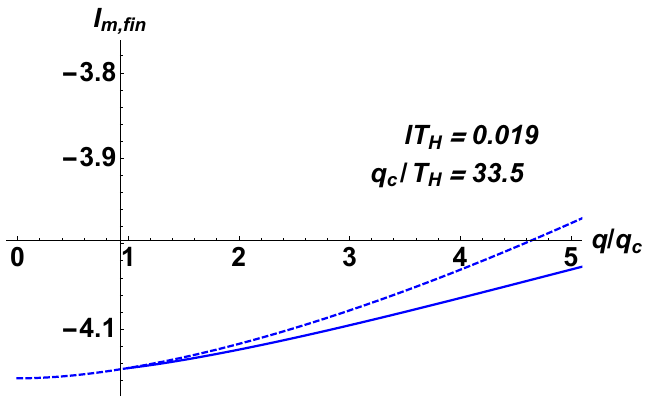
Figure 3 . I m;fin as a function of q=q c at lT H = 0 : 019 with T H = 0 : 15 and g 2 curve is for a AdS 3 charged black hole corresponding to the uncondensed phase, q < q c . The solid curve is for the condensed phase described by a hairy black